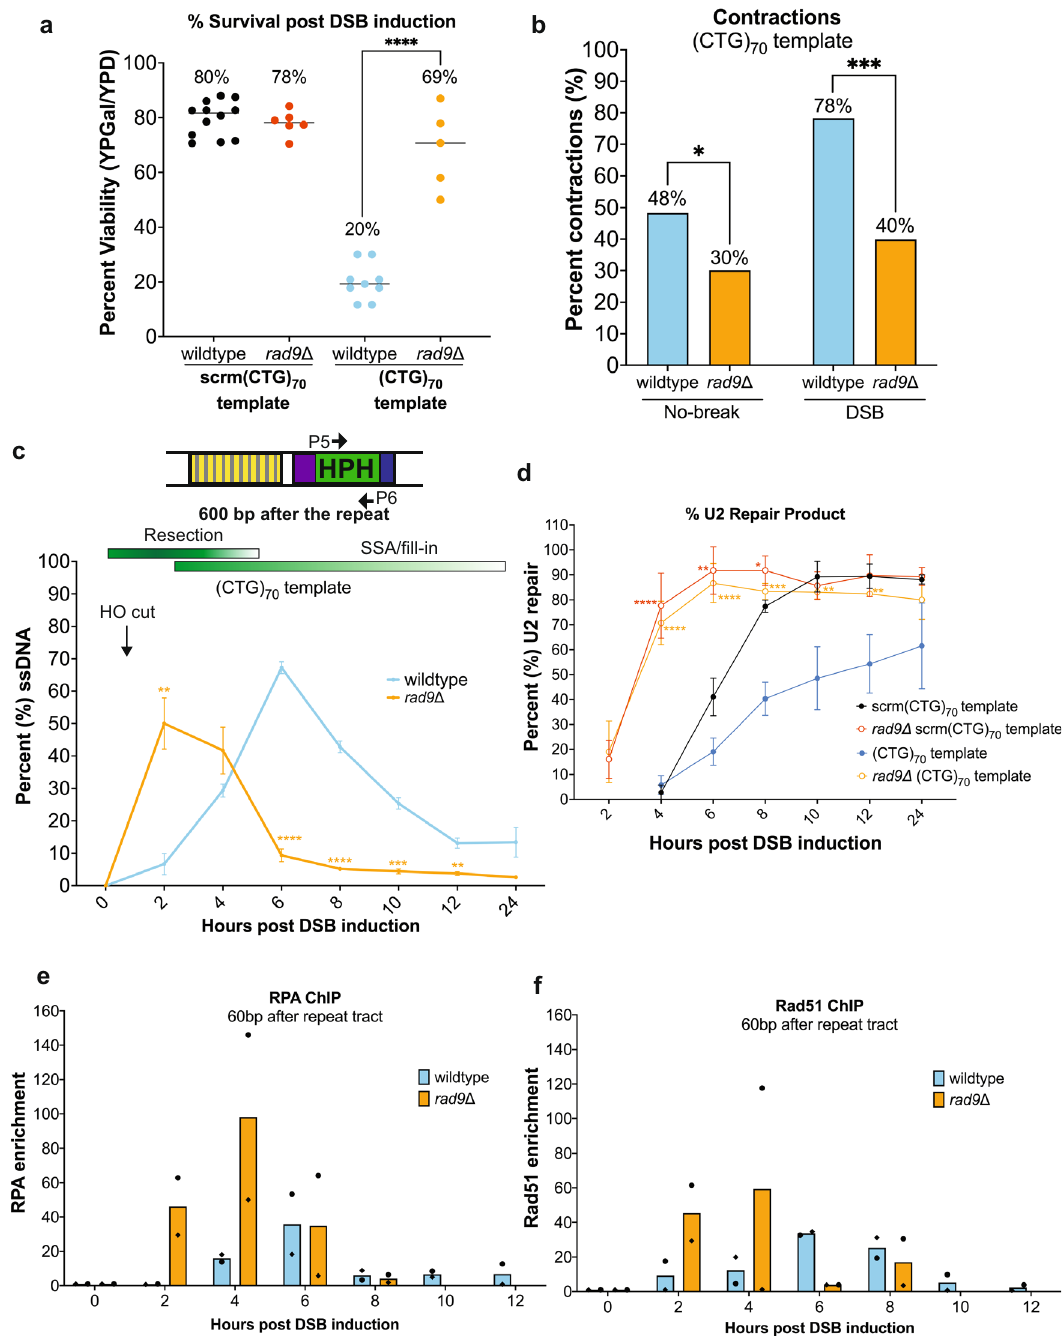
Fig.5|Deletionof RAD9 rescuesthedecreasedviabilityandgap fi ll-inmediated (CTG) 70 contractions. a For the scrm(CTG) 70 template strain, percent viability of the rad9 Δ mutant ( n =6) is unchanged compared to wildtype ( n =12). For